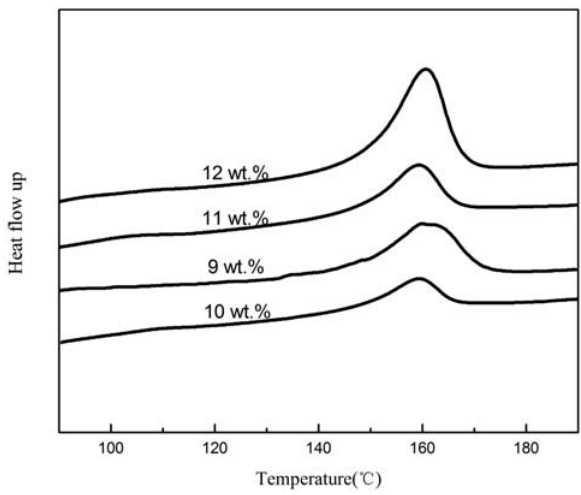
Fig. 2. DSC thermograms of different concentration of TPU/ VDF/PS Table 1. Thermodynamic properties of different concentration of TPU/PVDF/PS Sample ΔΔ H TPU/PVDF/PS (9